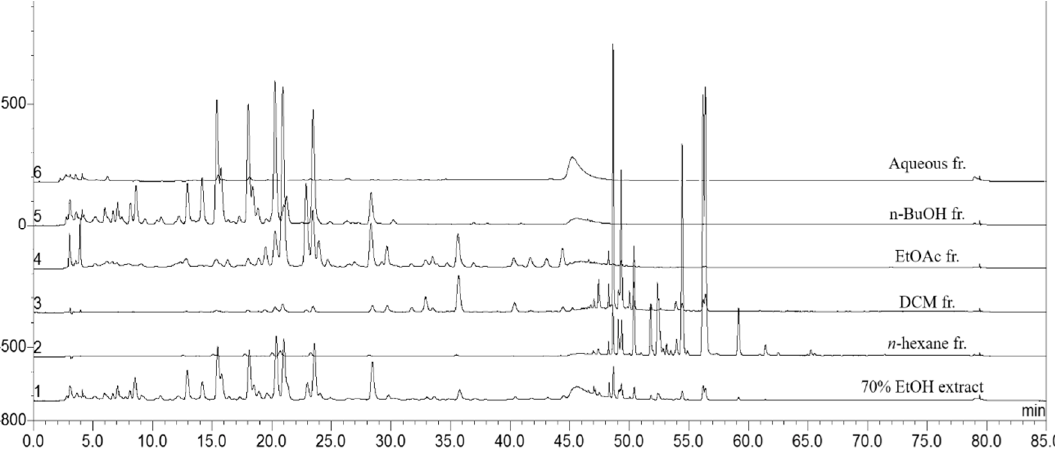
Figure 1. HPLC chromatogram from seed of Cassia tora of total extract and its fractionation.